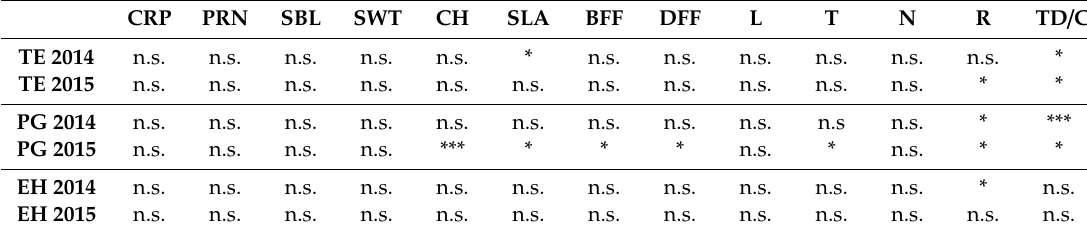
EH 2014 ASC: agroecological service crop; TE: termination; PG: plant growth; EH: end of harvest. 2 CRP: creeping vs. not creeping species; PRN: perennial life form vs. annual; SBL: long-term seed bank longevity vs. short-term; SWT: seed weight; SLA: specific leaf area; BFF: beginning of flowering (flowering onset); DFF: duration of flowering (flowering span); L: light a ffi nity; T: temperature; N: soil nutrient condition (N, T and L, Ellenberg and Pignatti